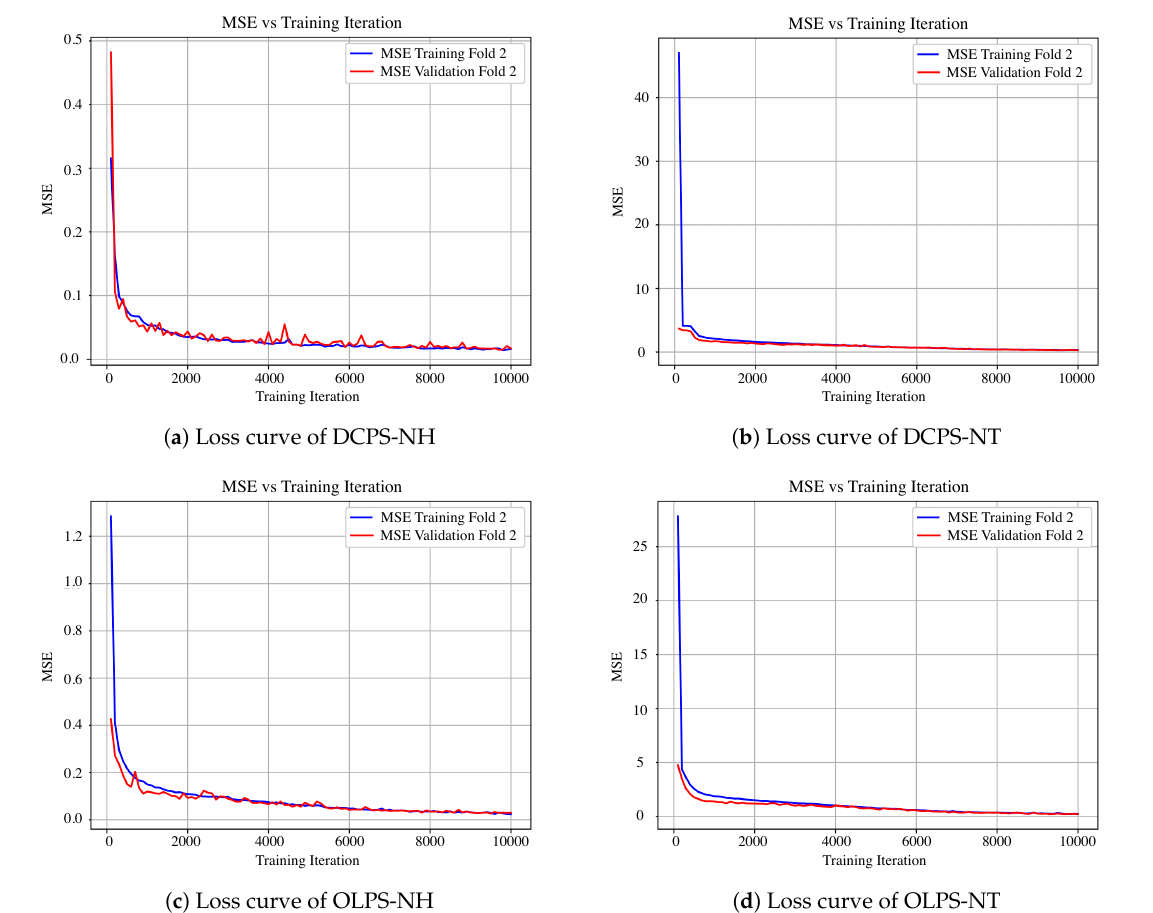
Figure 14. Loss curves for DCPS and OLPS structures. Loss values correspond to MSE values between real and predicted outputs throughout the training